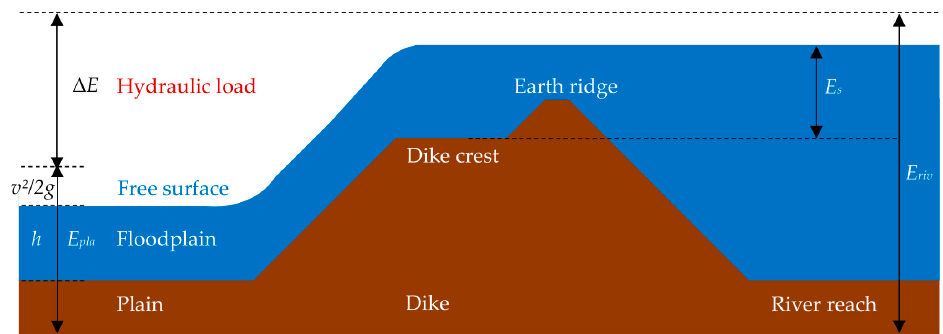
Figure 2. Scheme profile cross-sectional of a dike (surmounted by an earth ridge) with variables used to identify breach initiation. v (m/s) is mean flow velocity. to identify breach initiation. v (m/s) is mean flow